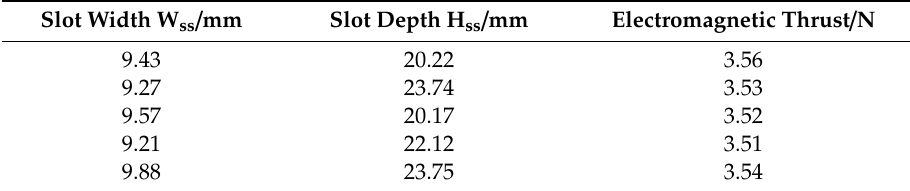
Table 2. Specific values of genetic algorithm optimization.